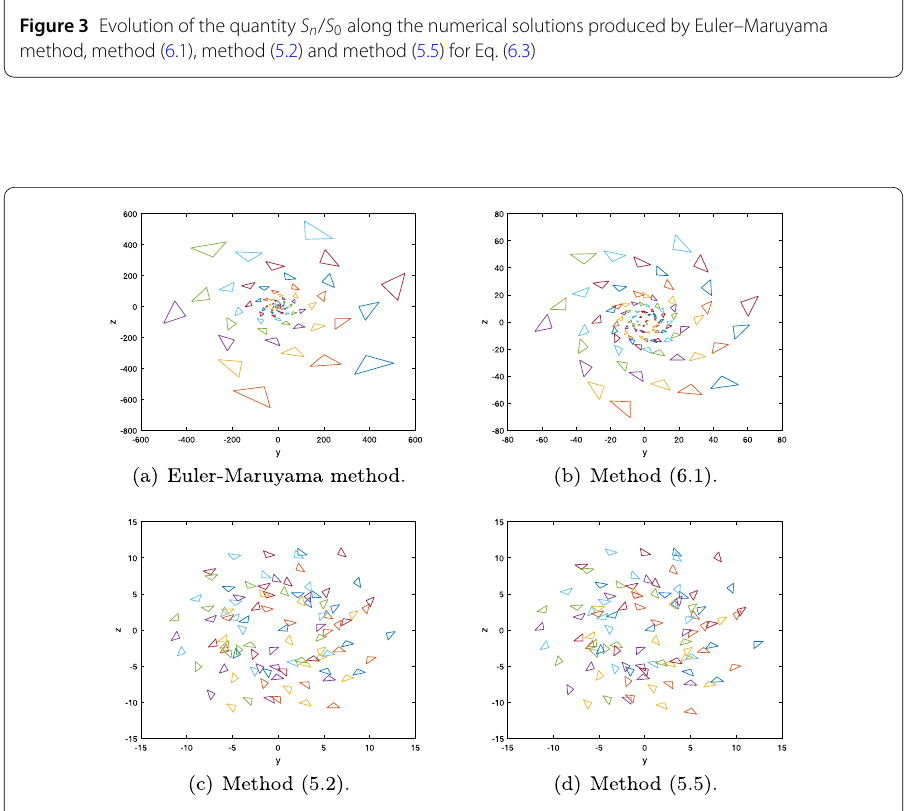
Figure 4 Evolution of the numerical triangles arising from Euler–Maruyama method, method (6.1), method (5.2) and method (5.5) for Eq.